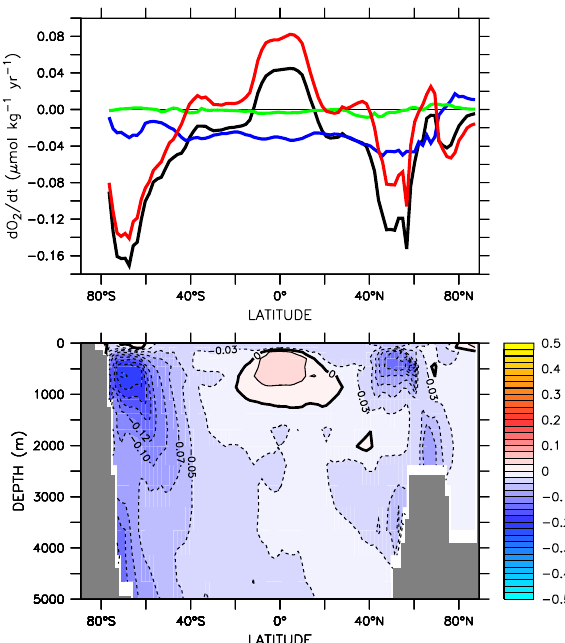
Fig. 6. Top panel: Zonally averaged change in simulated oxygen at 300dbar (black curve as in Fig. 5), the contribution due to changes in solubility diagnosed from simulated changes in temper- ature and salinity on the 300dbar surface (blue), changes of sim- ulated biotic oxygen consumption on the 300dbar surface (green) and transport processes, which are computed as the residual be- tween total oxygen changes and the sum of solubility and bioti- cally induced oxygen changes (red). Bottom panel: Zonally aver- aged change in simulated dissolved oxygen between 1960 and 2010. Units areµmolkg − 1 yr − 1 .